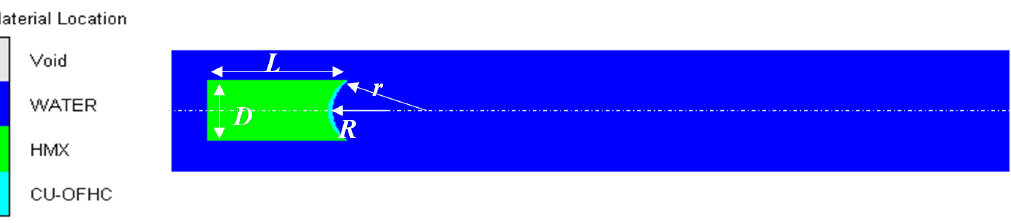
Figure 3. Numerical model of the underwater explosion of a shaped charge without an air cavity.